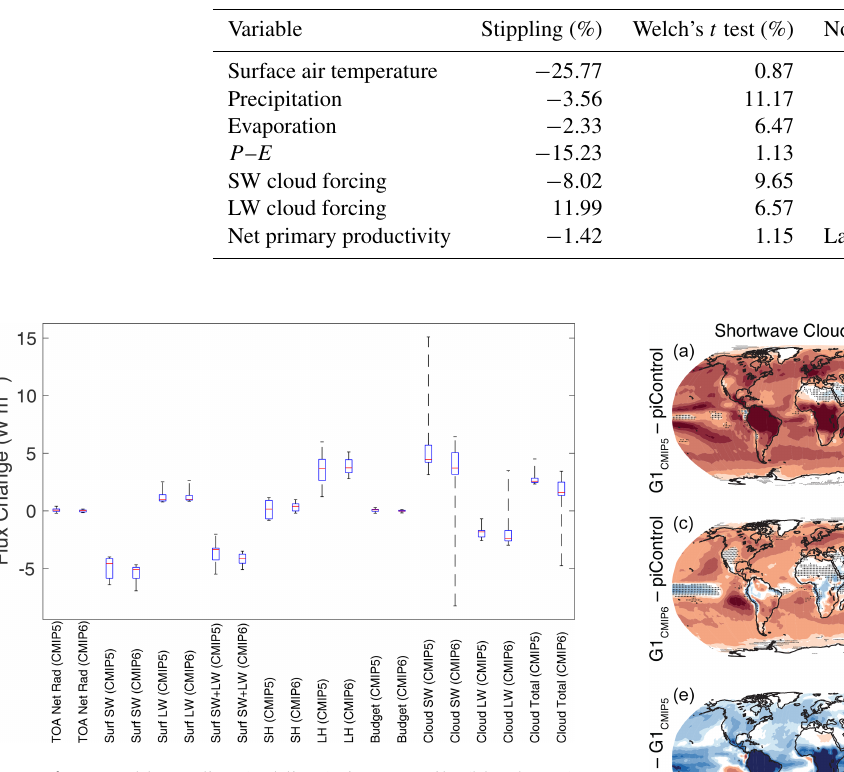
Figure 4. Ensemble median (red lines), interquartile (blue boxes), and ranges (black whiskers) for the same global mean energetic quantities as in Fig. 3 (G1 minus piControl) for both the CMIP5 and CMIP6 ensembles.